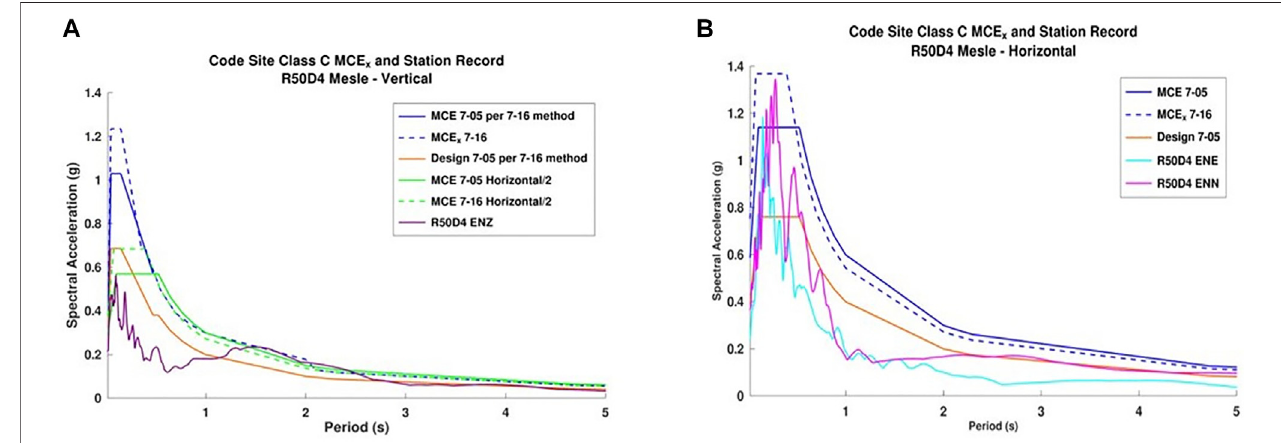
FIGURE 6 | Spectral accelerations at R50D4 from the 14th August 2021 earthquake. (A) vertical component. (B) horizontal motion. MCE is maximum credible earthquake, showing the 7 – 05 and 7 – 15 ASCE/SEI standards, and the design spectra for the 7 – 05 standard, to which Haiti has a national annexe (MTPTC, 2013).